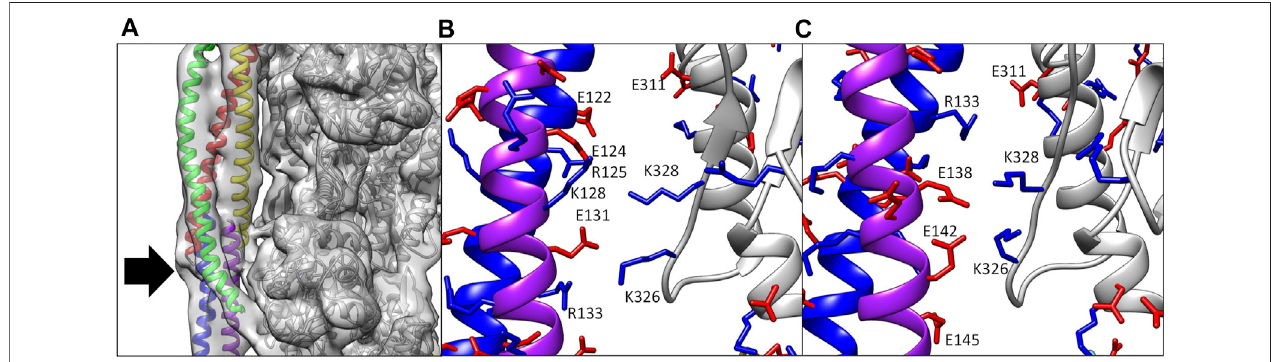
FIGURE2 |(A) Electrondensity map ofthecardiac thin fi lament solved incalcium-free conditions. Note thetubular density forboth tropomyosin (red, yellow, blue, and purple ribbon) and TnT1 (green ribbon), which could be fi t by a number of potential structures. The only landmark here for the modeler is the N- and C-termini of tropomyosin(arrow). (B) Ca 2+ -boundmodel(Yamadaetal.,2020)showingpooralignmentofpositive(bluesticks)andnegativeresidues(redsticks)betweenactin(gray ribbon) and tropomyosin (blue and purple ribbons). (C) Ca 2+ -bound model (Pavadai et al., 2020) in a similar orientation as (B) . Note the improved alignment of charged residues after